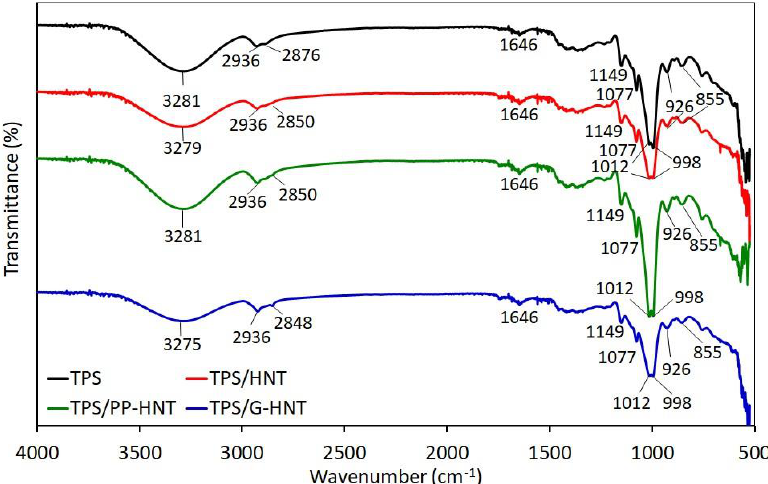
Figure 6. FTIR spectra of unmodified and halloysite-modified TPS in the 4000–500 cm − 1 region.